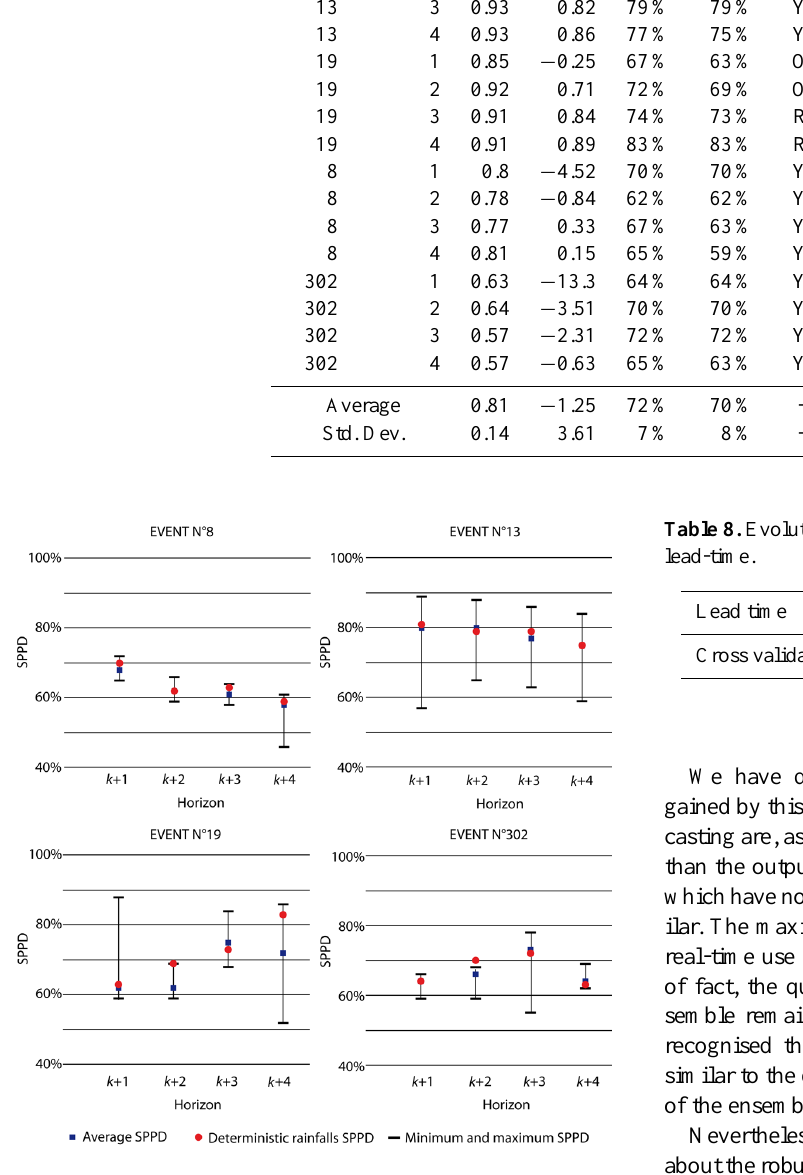
Fig. 10. Summary of results obtained from ensemble forecasting compared with deterministic forecasting output.